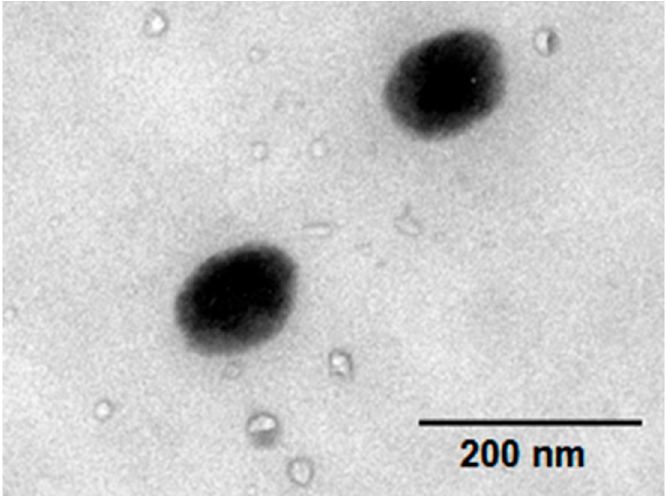
Figure 3. HR-TEM images of core-shell-structured latex particles.